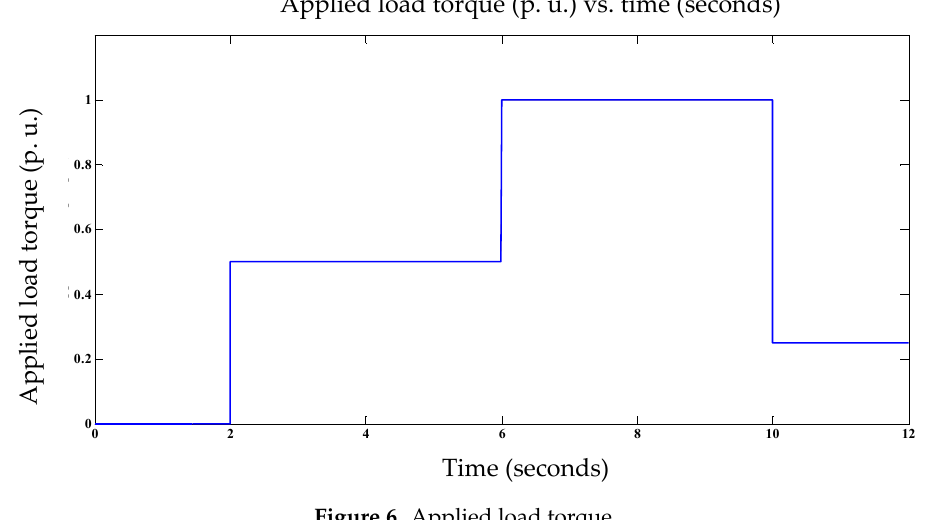
Figure 6. Applied load torque.